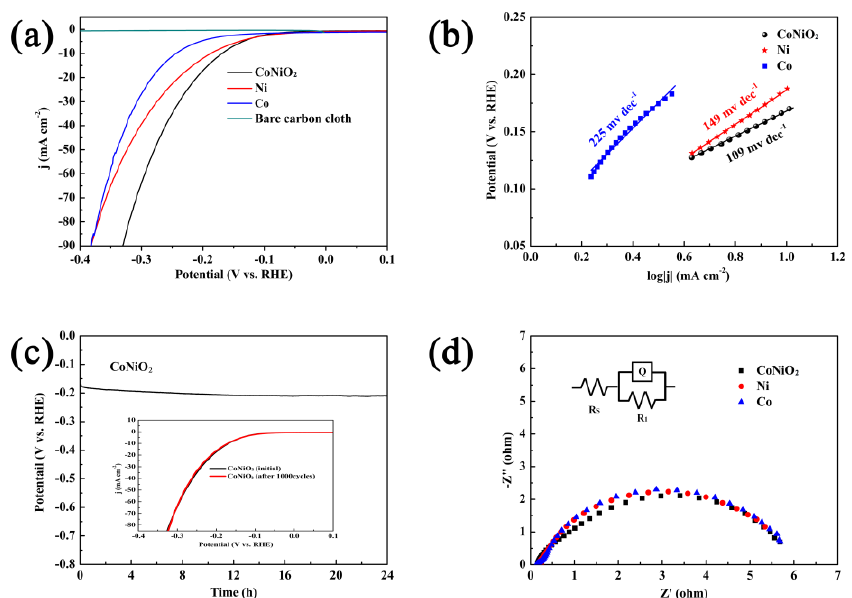
Figure 6. ( a ) Polarization curves and the corresponding ( b ) slopes of Tafel of CoNiO 2 , metallic Ni and metallic Co, respectively. ( c ) Chronopotentiometry curve of CoNiO 2 at 10 milliampere square centimeter for 24 h. This inset shows the polarization curves of the material before and after a 1000 cycles period. ( d ) Nyquist plots of the CoNiO 2 , metallic Ni and metallic Co at − 300 mV overpotential. Table 1. In 1 M KOH, CoNiO 2 electrocatalyst performance in HER was compared with that of cobalt- and nickel-based electrocatalysts.